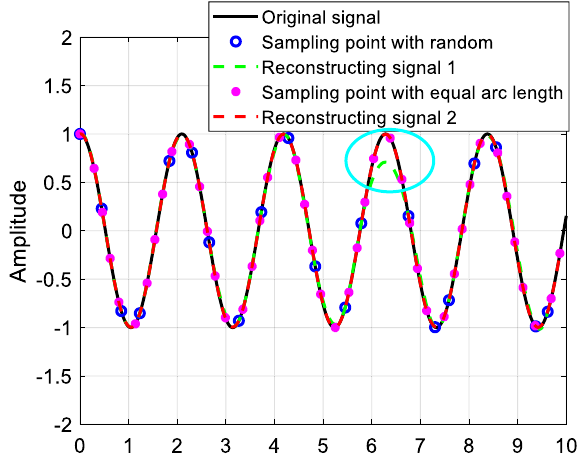
Fig. 5 Cosine signal, sampling points with random and equal arc length, and reconstructing signals,